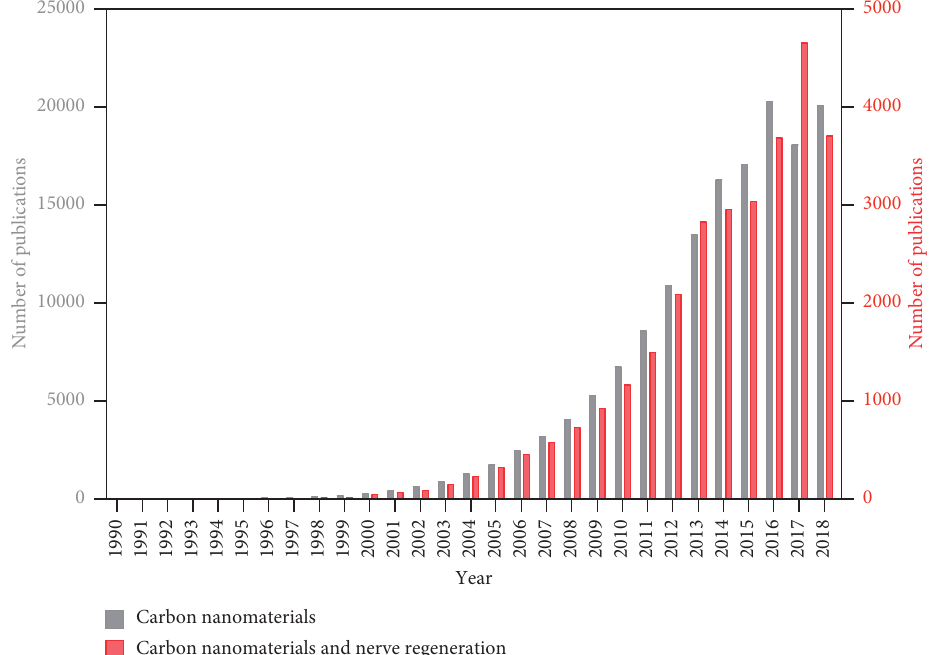
Figure 1: Increasing trend of reports on carbon nanomaterials (grey) and carbon nanomaterials and nerve regeneration (red). A google scholar search was performed on either “carbon nanomaterials” or “carbon nanomaterials and nerve regeneration” on the specified time